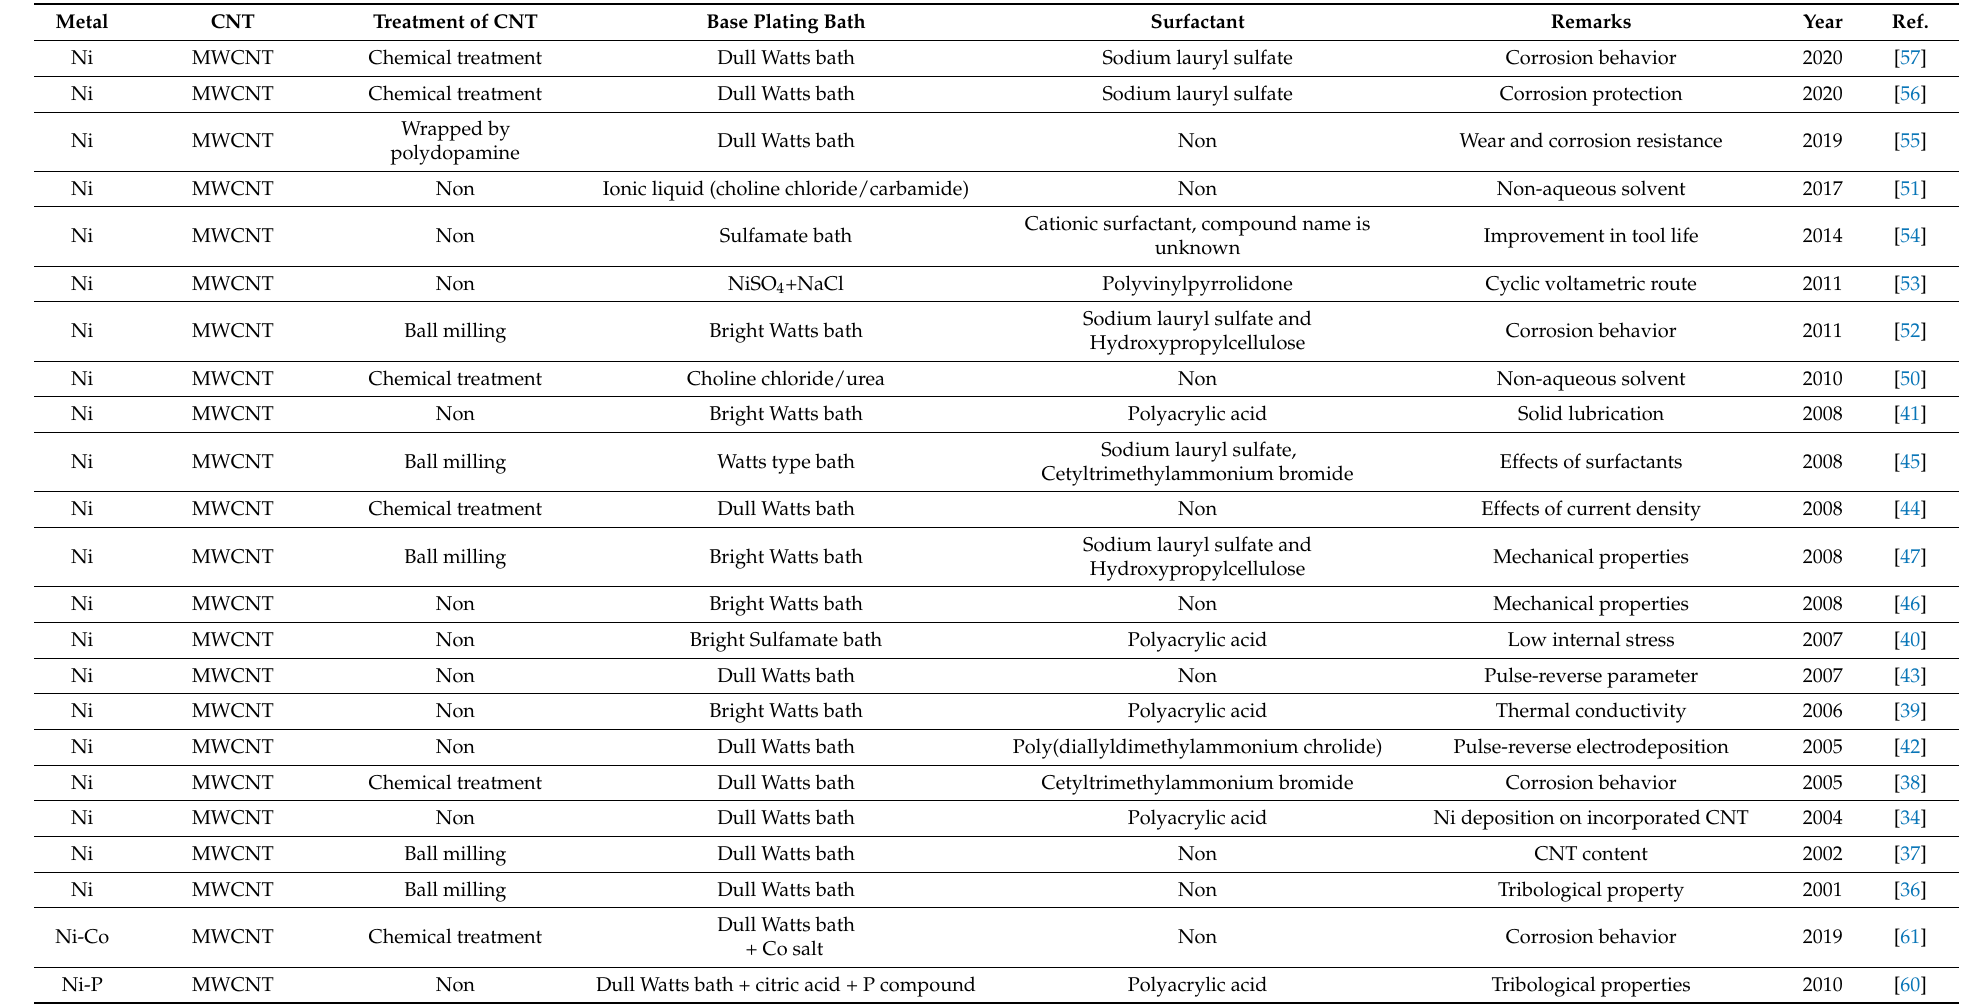
Table 1. Fabrication conditions of metal/CNT composites using composite plating by